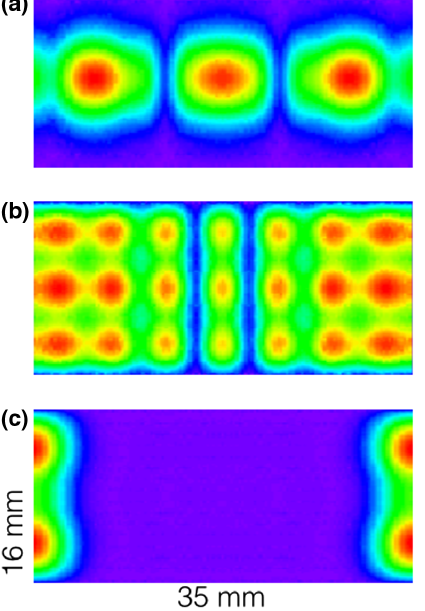
FIG. 25. Profile convergence vs cavity round trip N λ ¼ 20 μ m, (a) using a small cross section of gain, (b) and a c large